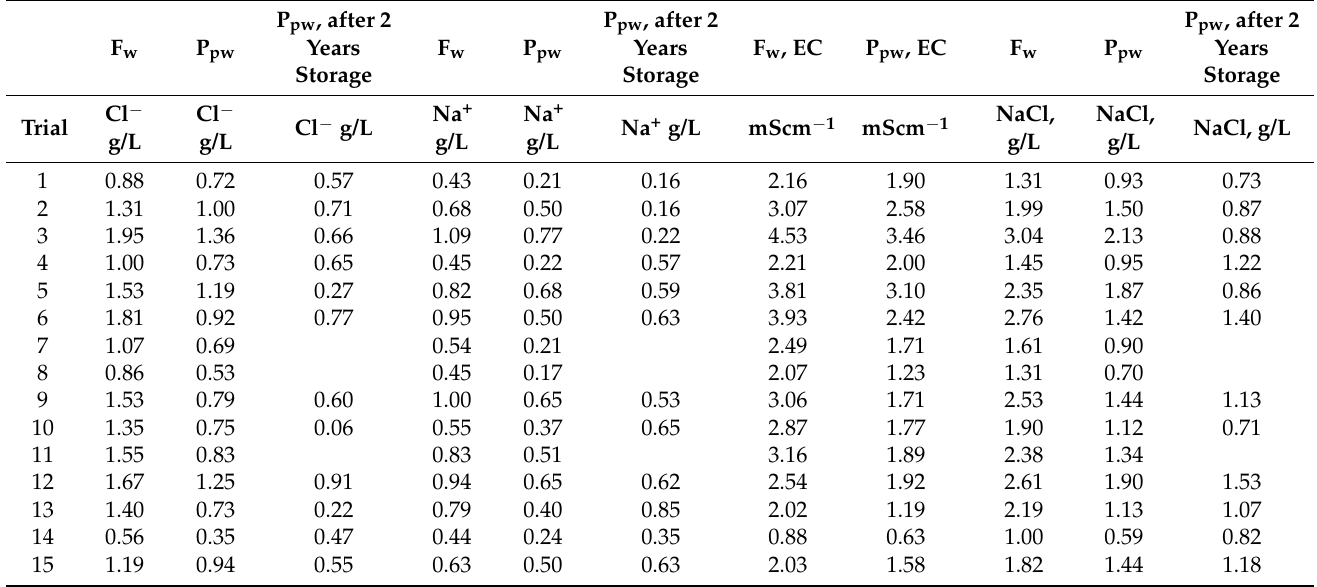
Table A2. Salinity data and ion concentrations associated with each trial. F w = feed water; P pw = prod- uct